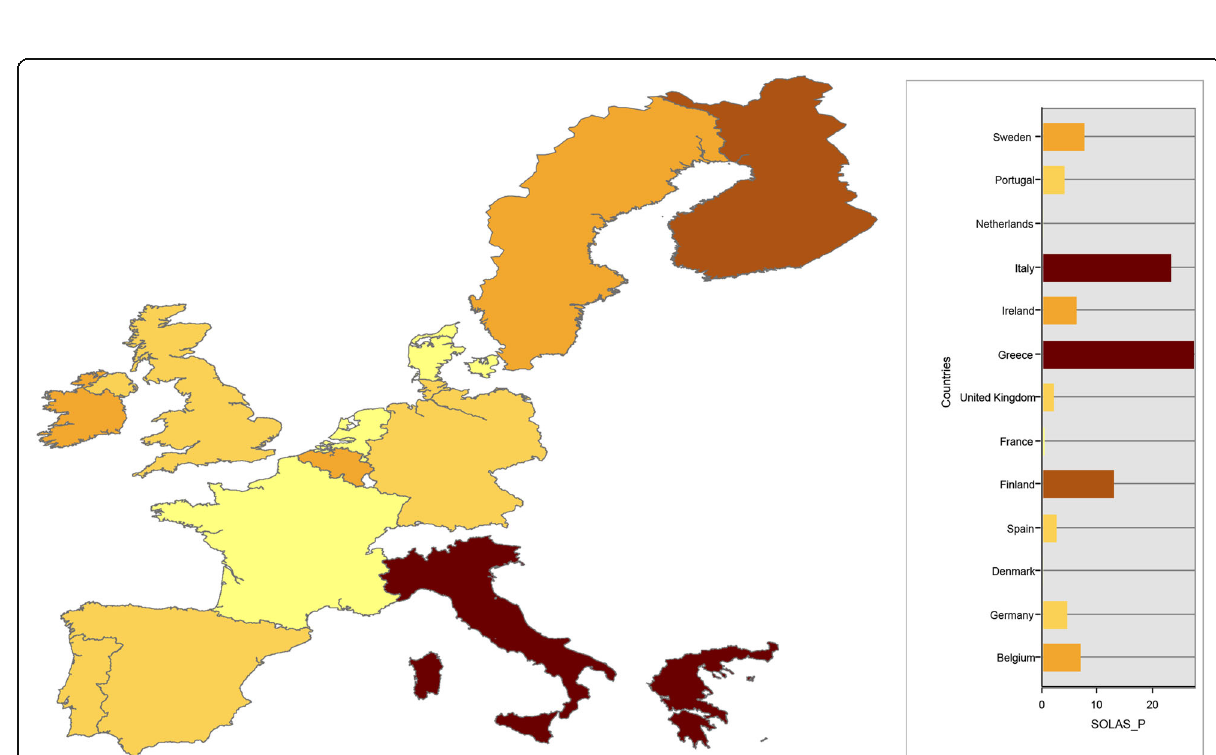
Fig. 4 Detainable remarks percentage for SOLAS Convention for EU15